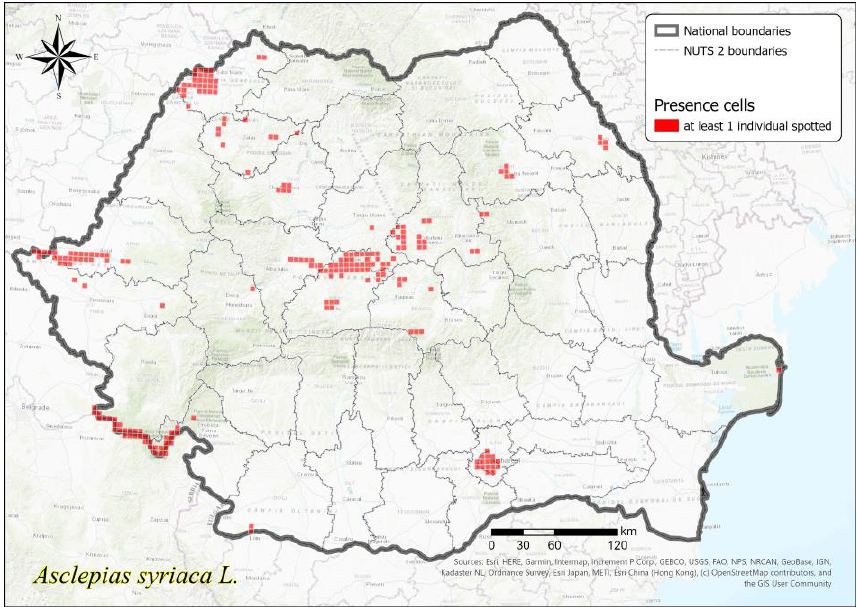
Fig. 2. Asclepias syriaca is reported especially from the centre and west of the country, with only a few recorded locations in the south, east or Danube Delta